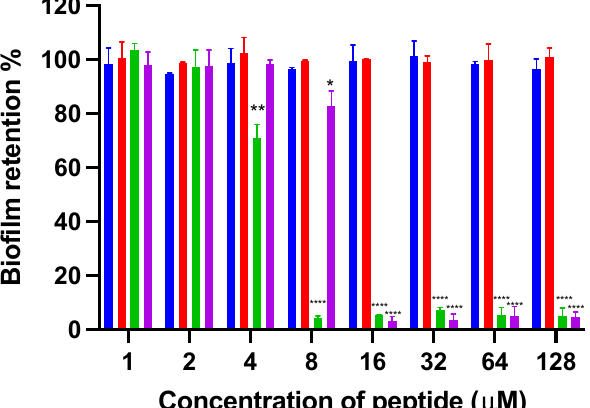
Figure 4. The inhibition of biofilm formation of kunitzin-OV 2 (blue), F9-KOV 2 (red), TAT-KOV 2 (green), and TAT-F9-KOV 2 (purple) against E. coli at the concentration from 1 to 128 µ M. The bacterial treated with norfloxacin (20 mg/L) and sterile LB medium (1% glucose) were used as the positive and negative controls in the biofilm formation inhibition experiment, respectively. The error bar represents the SEM of nine replications in three experiments and the significant difference results were calculated by comparing various treatments with the negative control (* p < 0.05, ** p < 0.01, and **** p < 0.0001).